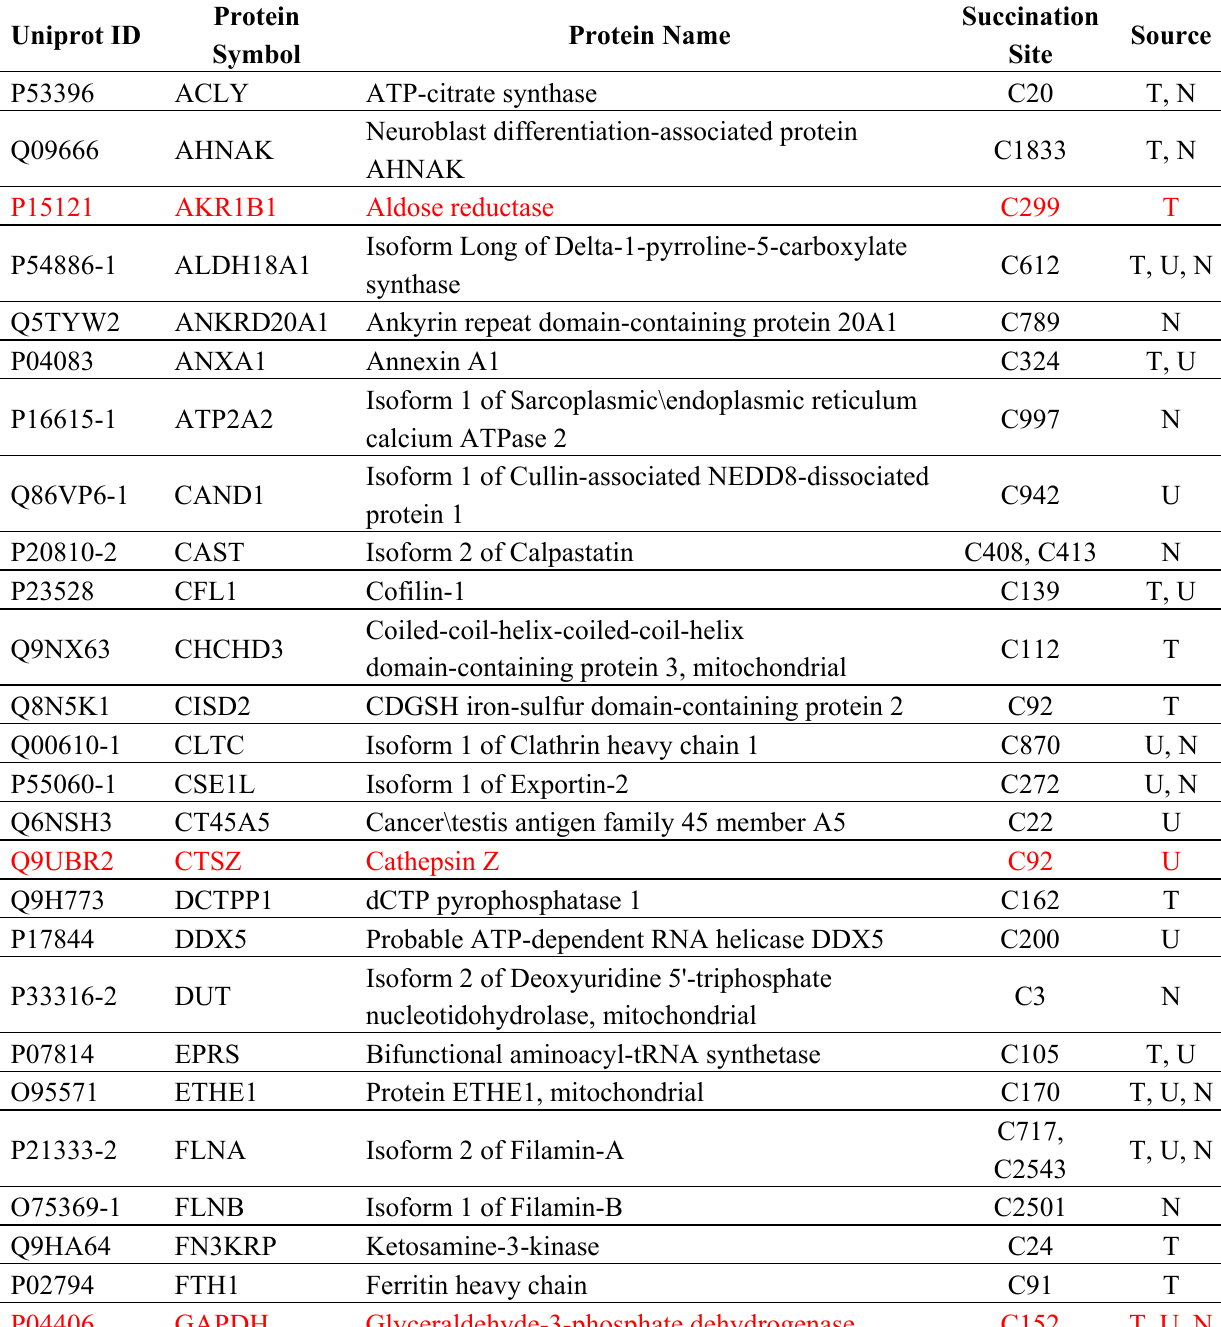
Table 1. Succinated proteins in HLRCC cancers and derived cell